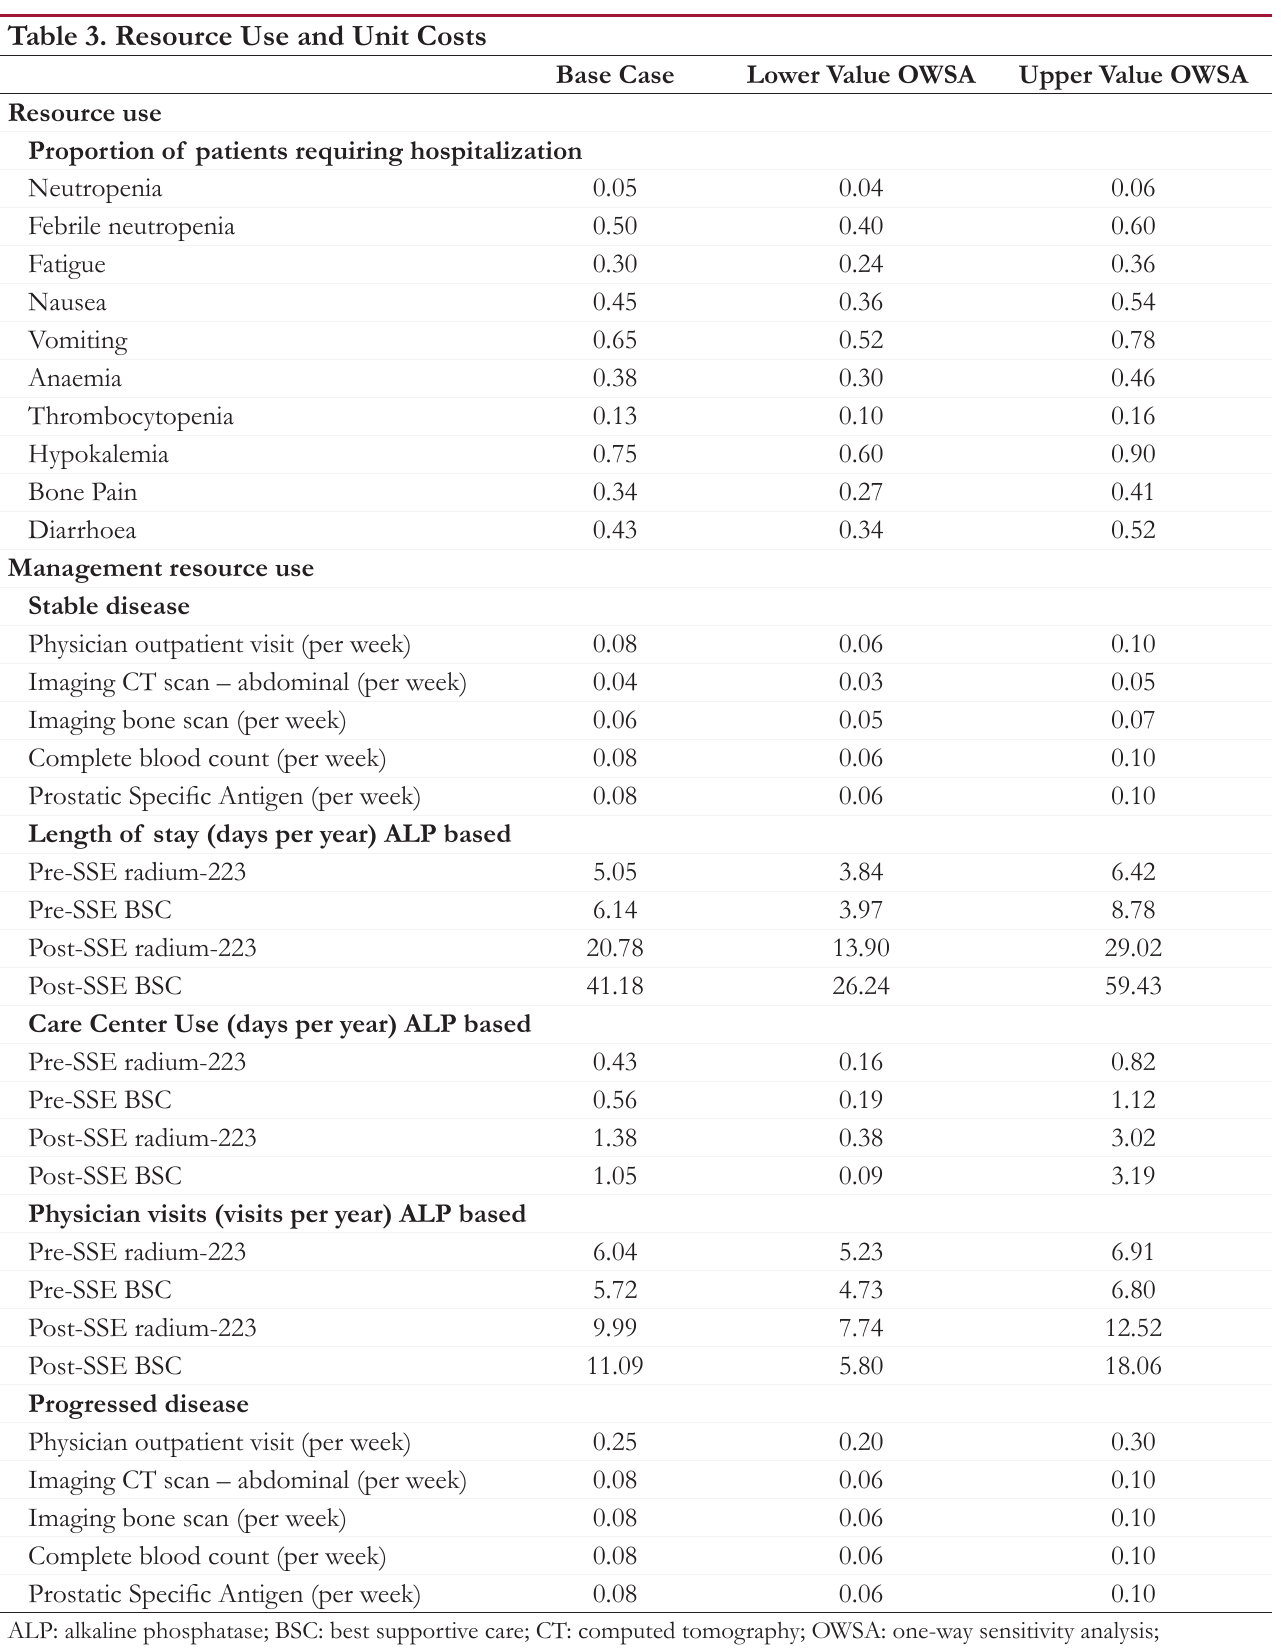
Base Case Lower Value OWSA Upper Value OWSA